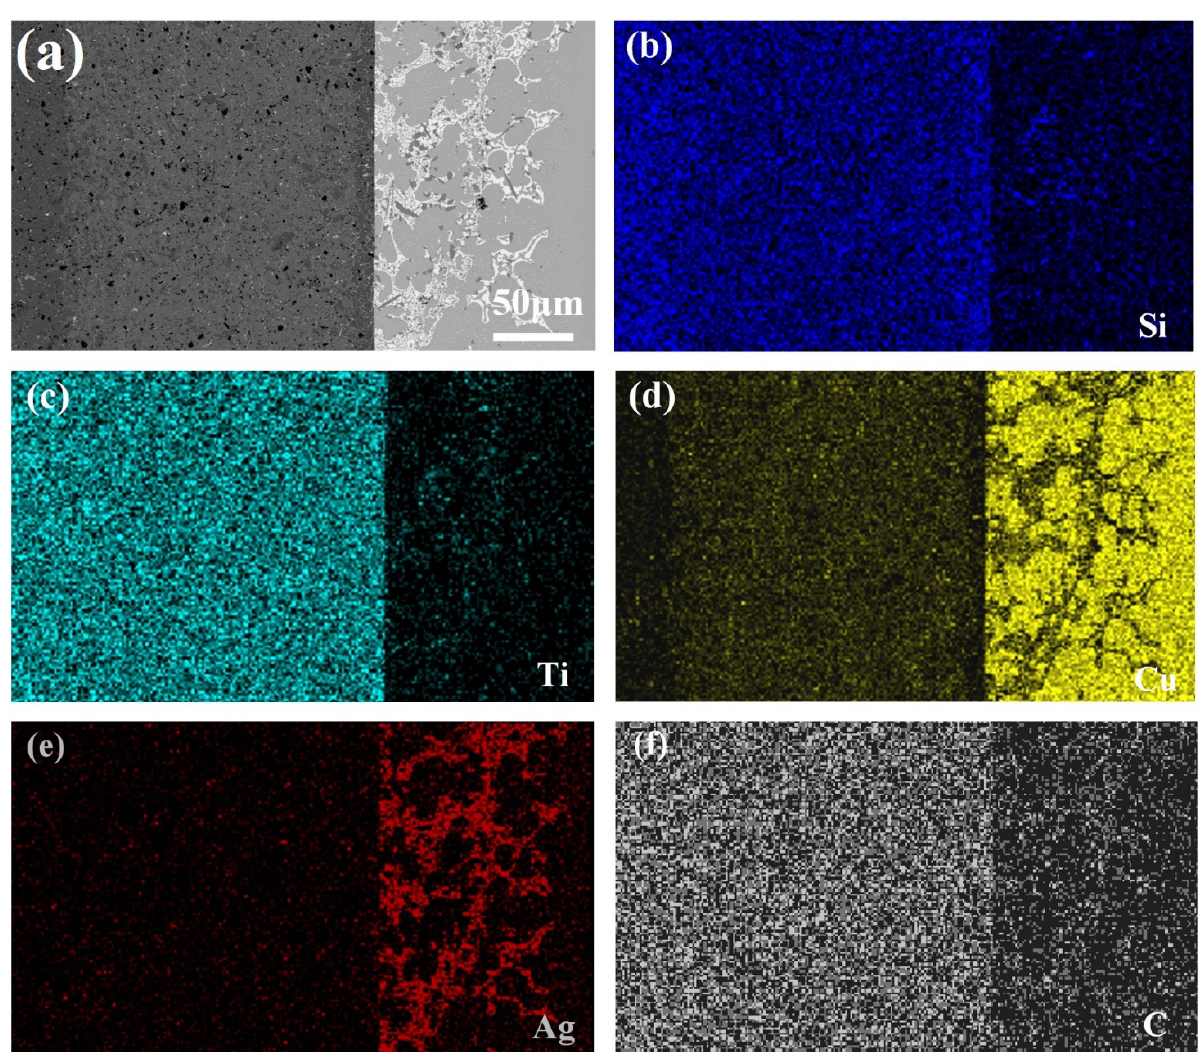
Figure 5. The area of surface scanning ( a ) and EDS maps of ( b ) Si, ( c ) Ti, ( d ) Cu, ( e ) Ag, and ( f ) C. Table 2. Compositions and possible phases of each spot marked in Figure 4d (at.